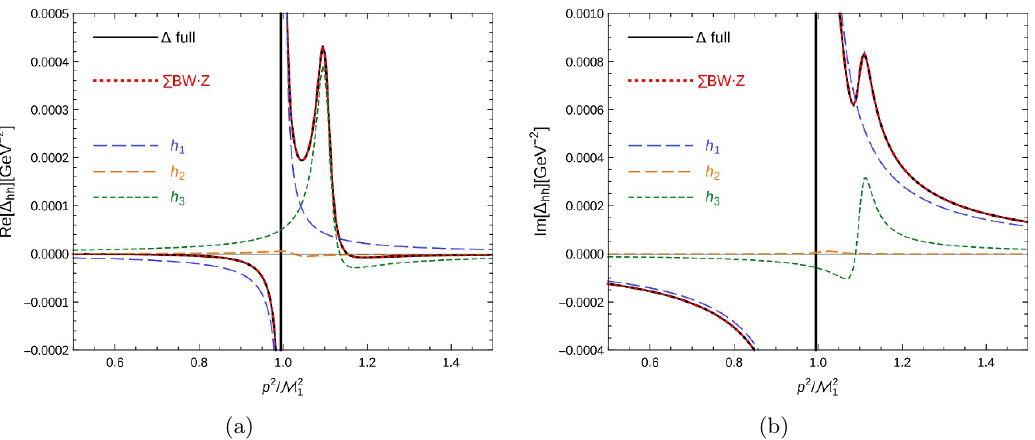
Figure 5 . Diagonal propagator (cid:1) hh ( p 2 ) depending on the complex momentum p 2 around M 2 p 2 = M 2 = 0 : 5 : : : 1 : 5. (a) real part, (b) imaginary part. The full propagator (cid:1) hh (black, labelled 1 by (cid:1) full) is compared to the sum of Breit-Wigner propagators weighted by ^ Z -factors according to eq. (4.14) (red dotted, labelled by P BW (cid:1) Z). The individual contribution of h a , i.e. ^ Z